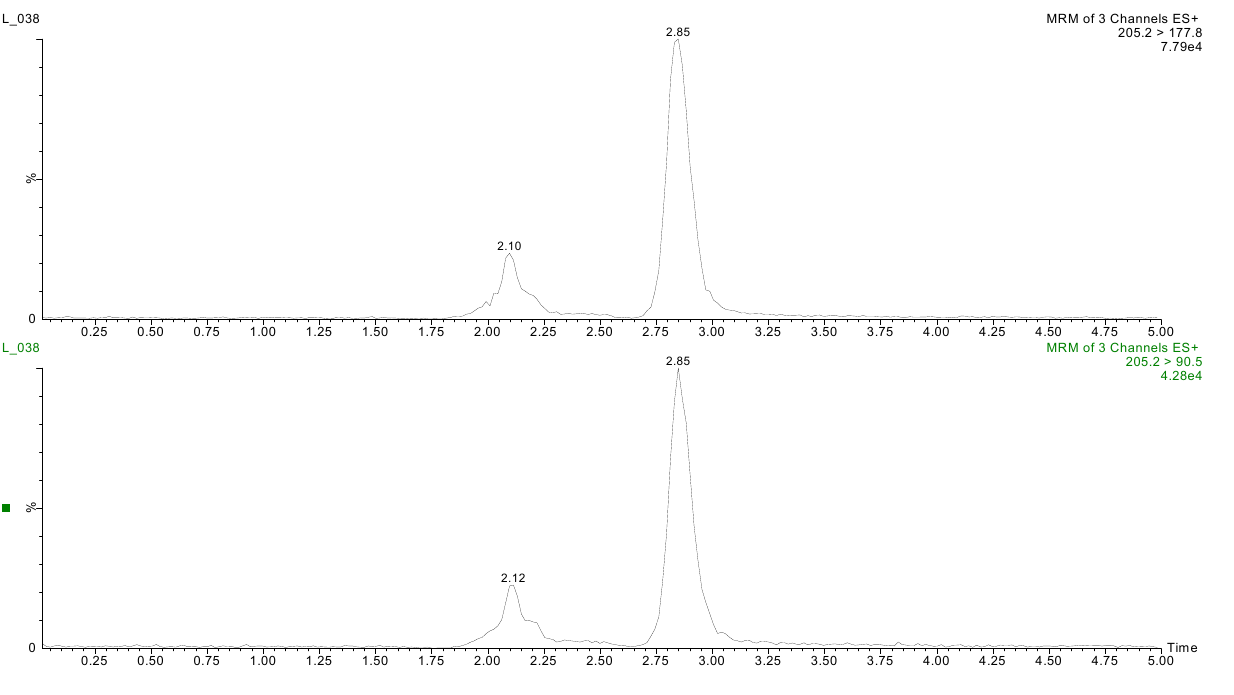
Figure A7. Chromatogram of the treated chicken muscle sample 24 h after treatment.